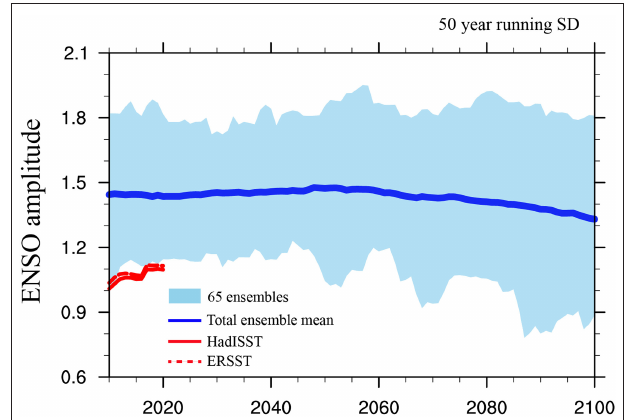
FIGURE 1 | ENSO amplitude in the 65-ensemble members from CESM-LENS and GFDL-LENS and observation (red). The 50-year running standard deviation of the Nino 3.4 SST index from each ensemble without a linear trend is calculated in each 50-year running window for the 65 simulation period of 1960–2100. Solid (dashed) red line indicates the HadISST (ERSST) observation for 1960–2021 and thick blue denotes the ensemble mean ENSO amplitude. Note that the last year of each 50-years running period is plotted on the x- axis. For example, the ENSO amplitude at 2020 indicates the ENSO amplitude for 1971–2020. Unit is ◦ C.